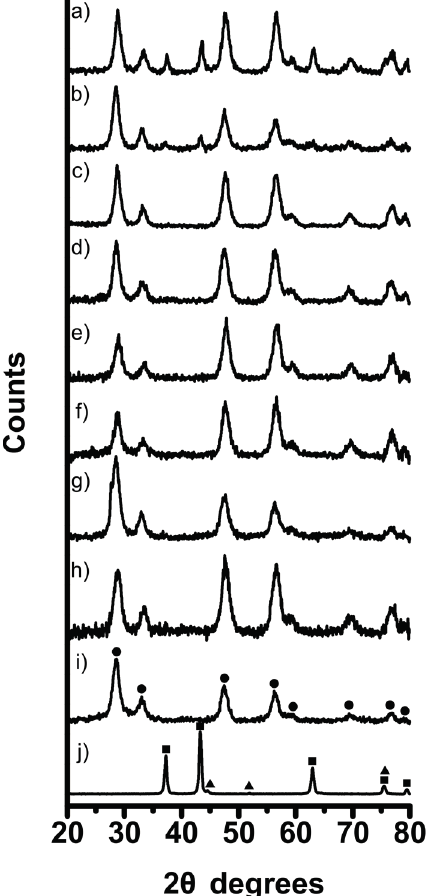
Figure 4. Powder X-ray diffraction patterns of: ( a ) Sample 3 (50% Ni-CeO 2 , annealed); ( b ) Sample 4 (10% Ni-CeO 2 , annealed); ( c ) Sample 5 (8% Ni-CeO 2 , annealed); ( d ) Sample 6 (5% Ni-CeO 2 , annealed); ( e ) Sample 7 (4% Ni-CeO 2 , annealed); ( f ) Sample 8 (3% Ni-CeO 2 , annealed); ( g ) Sample 9 (2% Ni-CeO 2 , annealed); ( h ) Sample 10 (1% Ni-CeO 2 , annealed); ( i ) Sample 1 (CeO 2 , annealed) and ( j ) Sample 2 (NiO, annealed). Circles represent the diffraction peaks from the standard pattern of CeO 2 (COD: 4343161), squares standard data from NiO (COD: 1010093) and triangles standard data from Ni metal (COD: